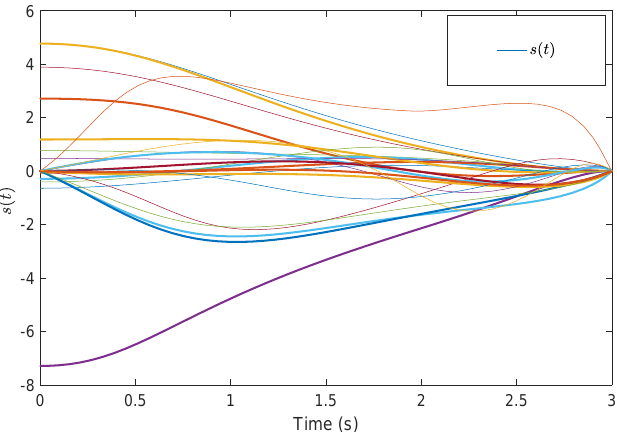
Figure 14. Intermediate states s (t) by the prescribed-time Controller